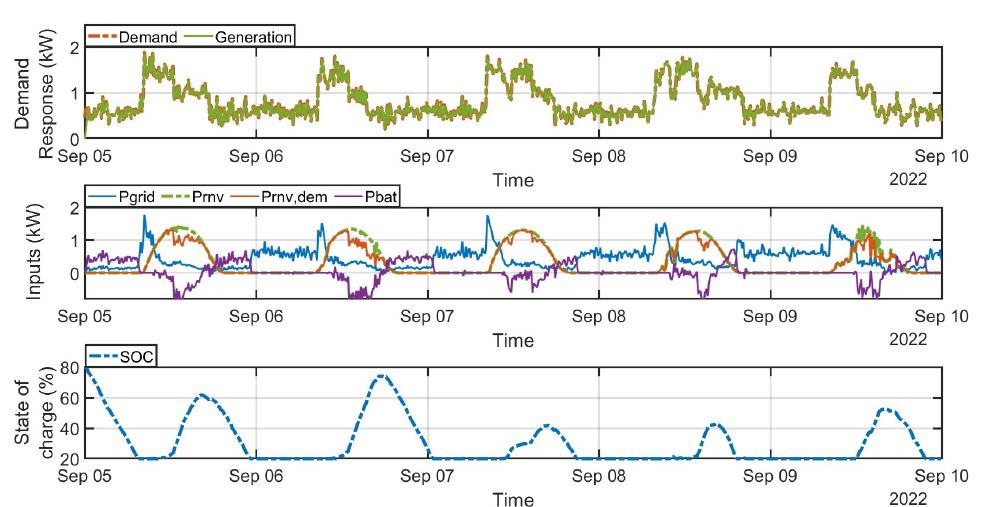
Figure 6. Demand response and battery